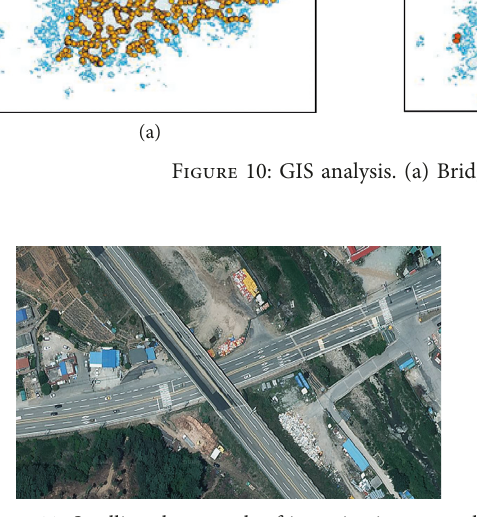
Figure 11: Satellite photograph of investigation example.